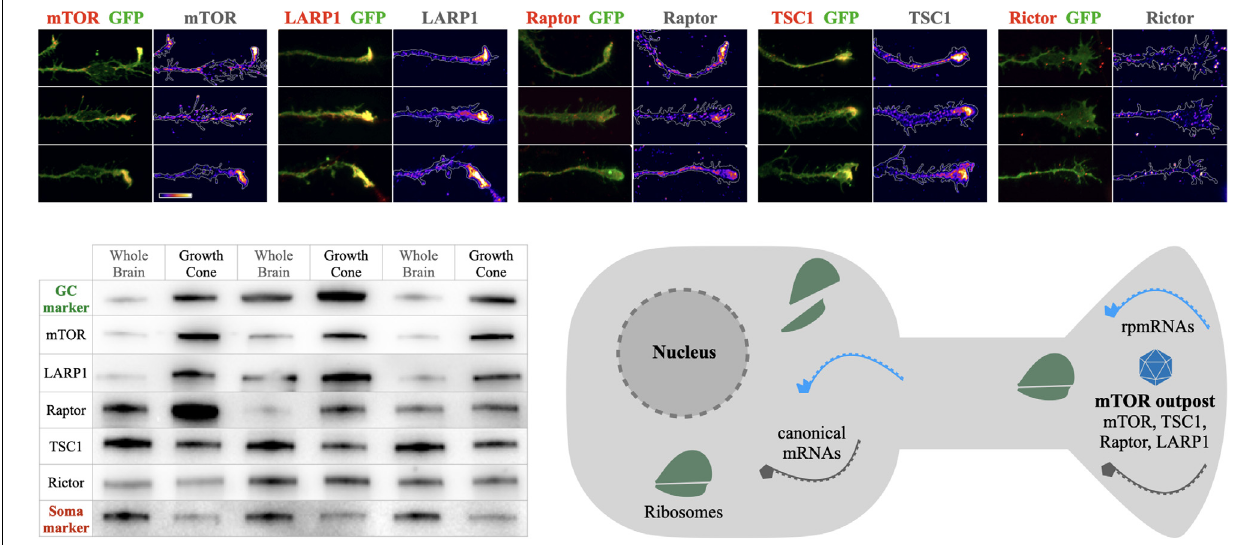
FIGURE 1 | mTOR outposts and the mTOR outpost model. Top panels: examples of mTOR outposts in axon growth cones of cultured cortical neurons seen as dense accumulations of mTOR, LARP1, Raptor, and TSC1, but not of Raptor. Green shows membrane-anchored GFP outlining the axon growth cone. Immunoreactivity of each protein is overlaid in red and shown alone in density heat maps. Scale bar is 10 µ m and shows heat map color-range from lowest (left) to highest (right) intensity. Bottom left: Western blots of newborn mouse brain lysates and growth cone fractions showing enrichments of mTOR and associated proteins imaged above. Growth cone marker GAP43 (GC marker, green) and cell body marker GM130 (Soma marker, red) shown for reference. Three independent subcellular fractionation experiments are shown, with whole brain lysates in odd lanes and growth cone fractions in even lanes. mTOR, LARP1, and Raptor are highly enriched in growth cones and depleted from soma-rich lysate, while TSC1 and Rictor are present, but not enriched in growth cones. Data panels are adapted from Macklis and colleagues (Poulopoulos et al., 2019). Bottom right: schema of the mTOR outpost model in a neuron. Local densities of mTOR and associated proteins, including Raptor (key subunit of mTORC1), TSC1 (master regulator of mTOR activation), and LARP1 (mTORC1 and TOP mRNA binding protein), accumulate in local densities into distal processes forming local mTOR outposts (shown as blue polyhedron). Ribosomal protein mRNA transcripts (rpmRNAs, light blue) with 5’ TOP motif that interact with LARP1 and mTORC1 for translation, are enriched in compartments together with mTOR